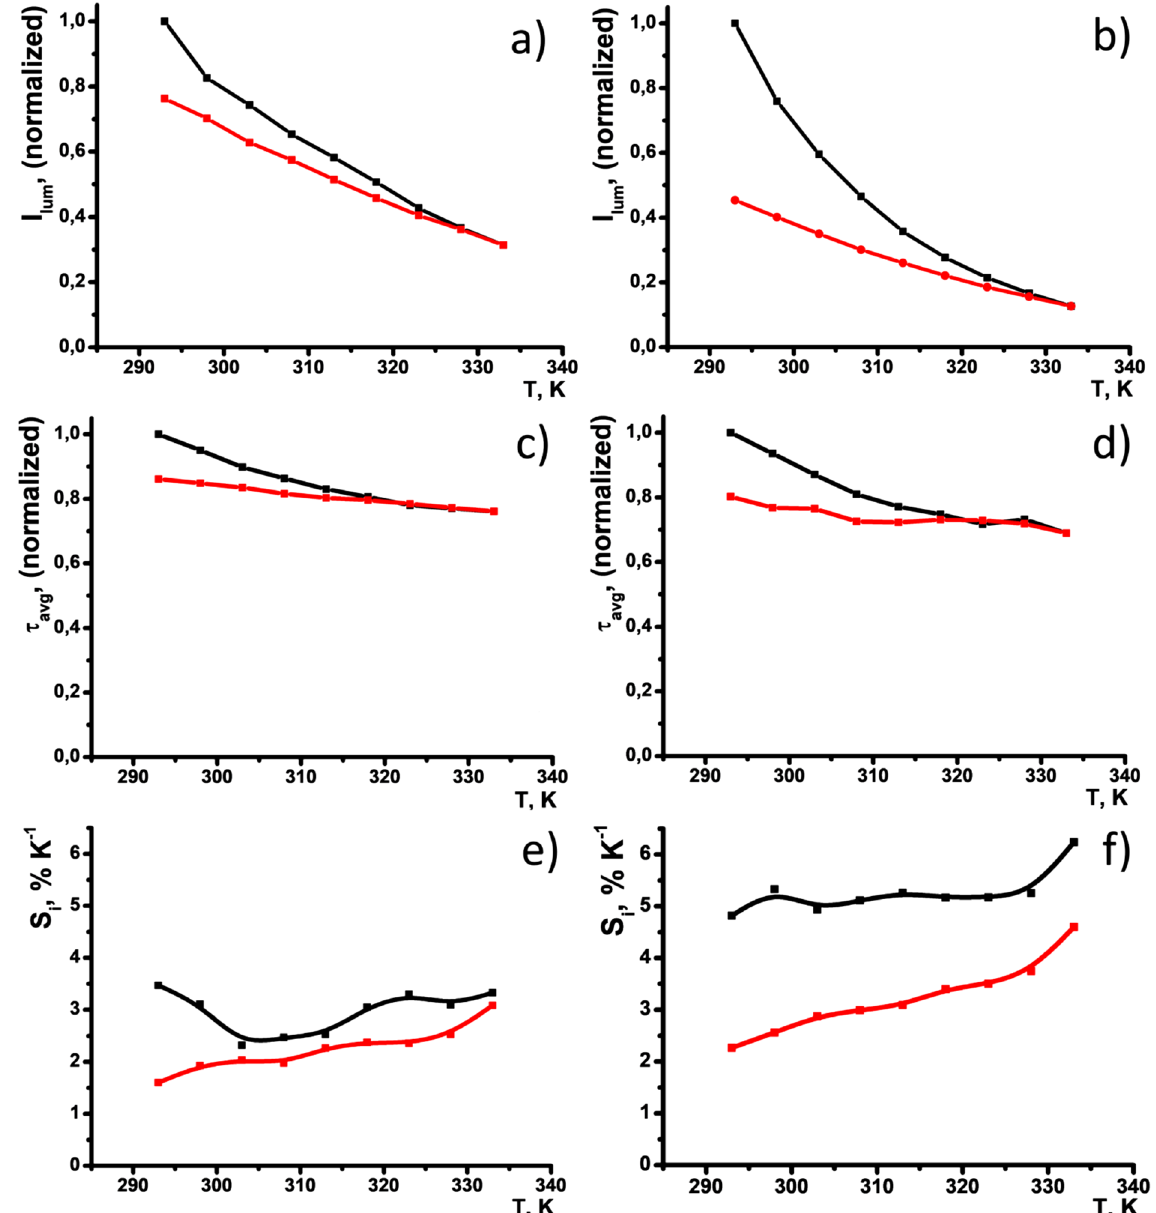
2 (TCA3) 2 ] ( a , c )) and PSS-[Tb 2 (TCA4) 2 ] ( b , d ) monitored within the range of temperatures 293–333 K upon heating (black) and cooling (red). S I values at different temperatures calculated from the luminescence intensity data for PSS-[Tb 2 (TCA3) 2 ] ( e ) and PSS-[Tb 2 (TCA4) 2 ] ( f